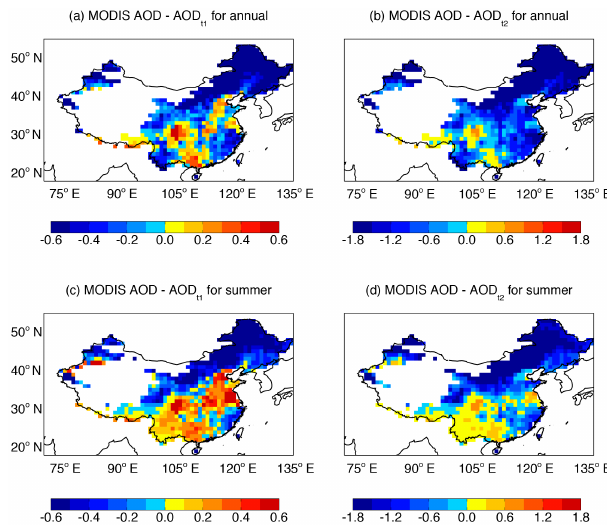
Figure 7. Differences between MODIS AOD and two derived AOD thresholds. Left panel shows (cid:49) AOD between MODIS and AOD t1 for the average of (a) whole year and (c) summer months. Right panel shows (cid:49) AOD between MODIS and AOD t2 for the average of (b) whole year and (d) summer months. For the left panel, regions with positive values indicate that increase (decrease) in local AOD leads to reductions (enhancement) in NPP, while regions with neg- ative values denote that decrease (increase) in local AOD results in reductions (enhancement) in NPP. For the right panel, regions with negative (positive) values indicate that current level of AOD always promotes (inhibits) NPP, compared with the aerosol-free conditions. The color scales among panels are different.